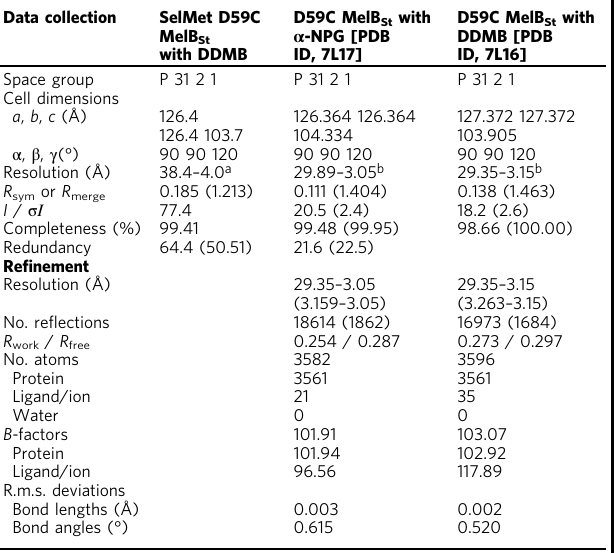
Table 3 Crystallographic Data collection, phase, and re fi nement